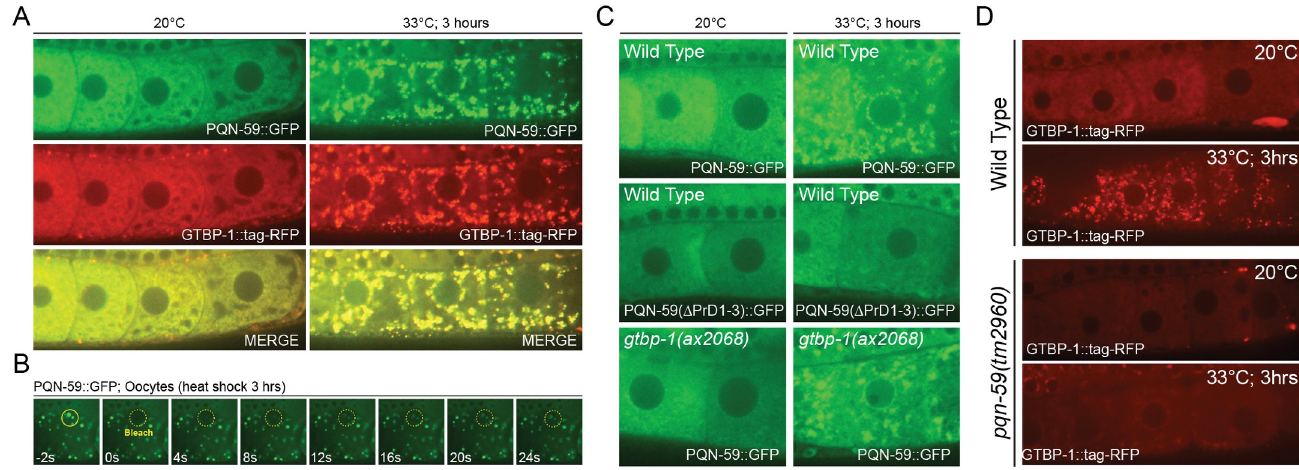
Fig 5. The “prion-like” domains of PQN-59 are essential for LLPS properties during heat stress and PQN-59 is important for the efficient localization of GTBP-1 to stress granules. (A) In developing oocytes, PQN-59::GFP is localized to the cytoplasm. At elevated temperatures, PQN-59::GFP re-distributes to cytoplasmically localized stress granules that co-localize with the core stress granule component GTBP-1::RFP. (B) FRAP analysis of heat stress-induced PQN-59:: GFP indicate that it is likely in a liquid-liquid phase separated state as PQN-59::GFP droplets recover fluorescence very rapidly when compared to PQN-59::GFP recovery at normal physiological temperatures (Fig 4I). (C) Condensation of PQN-59::GFP in heat stress conditions does not require GTBP-1 expression but does require the C-terminal “prion-like” domains of PQN-59. (D) GTBP-1 localization to stress granules in heat-shocked oocytes is severely compromised in the absence of